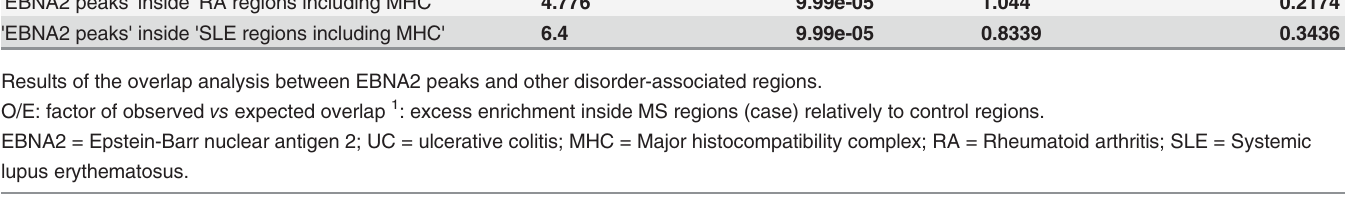
Results of the overlap analysis between EBNA2 peaks and other disorder-associated regions.